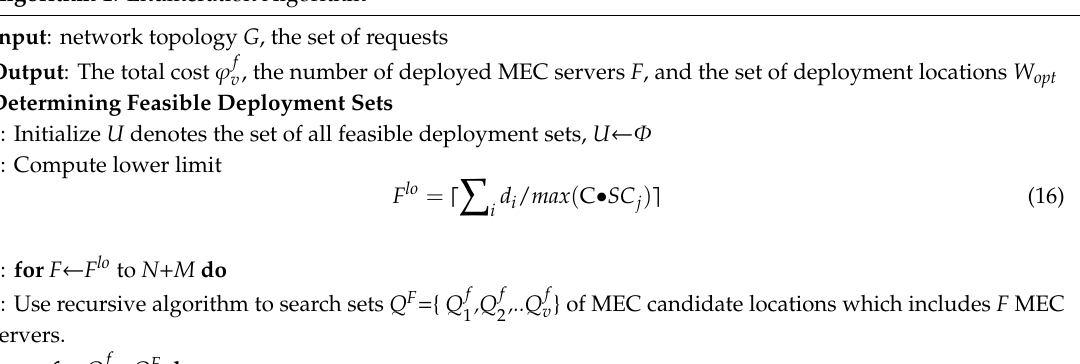
Calculating Total Cost of Feasible Deployment